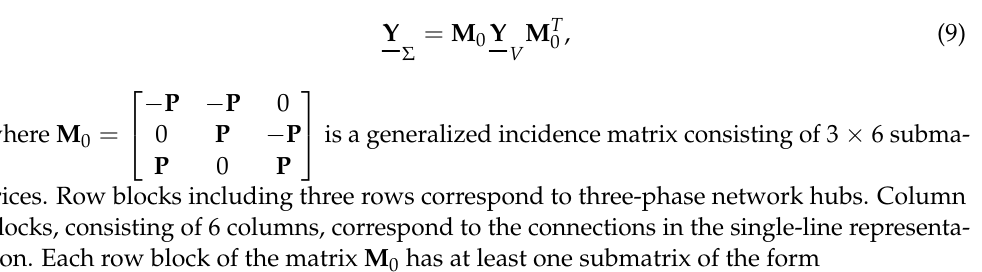
Phase coordinates are the most natural description of three-phase power systems.